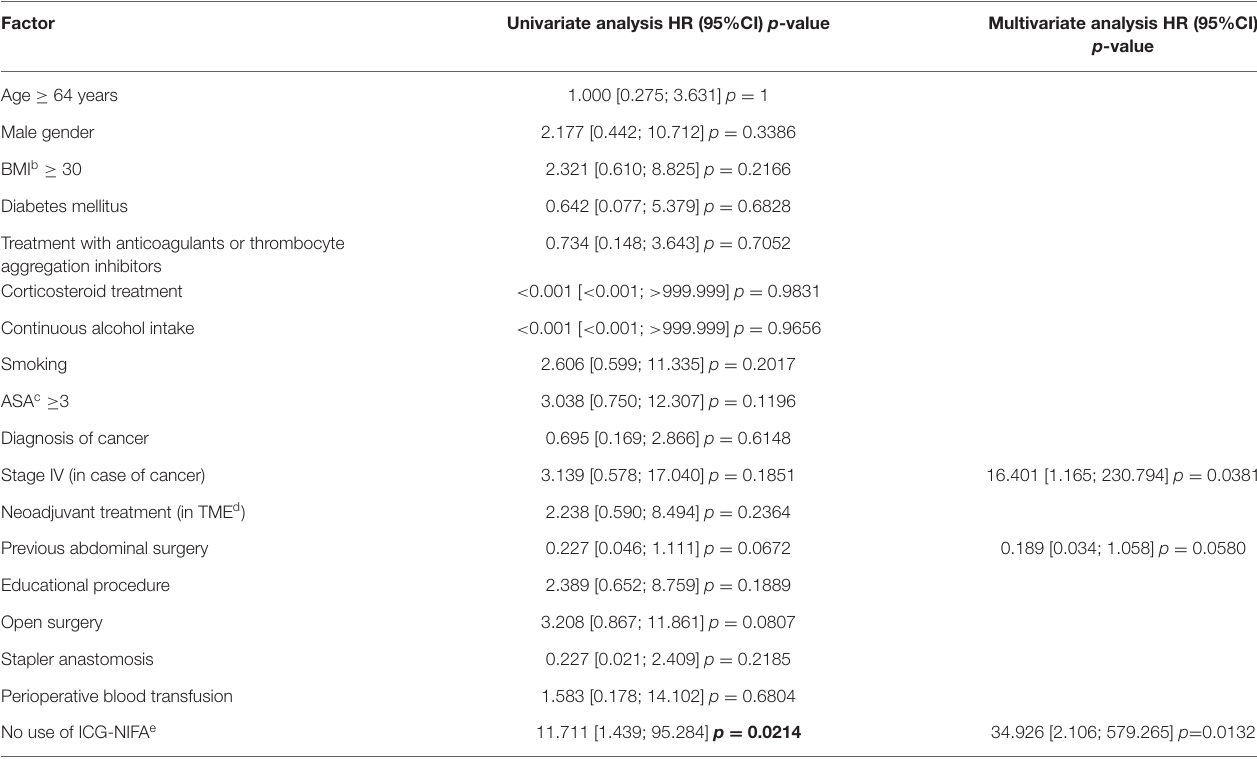
TABLE 3 | Uni and multivariate analyses of risk factors for the development of post-operative AL a .